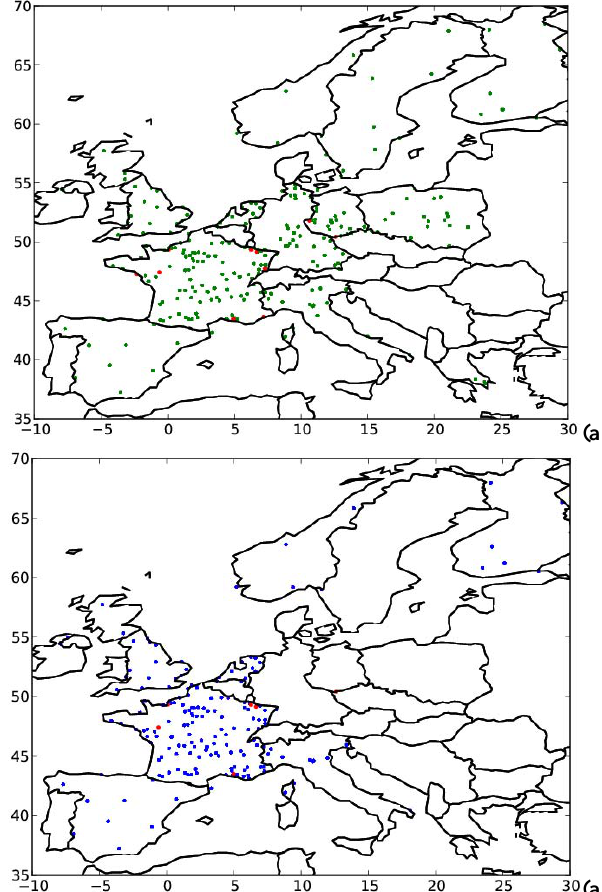
Fig. 8. Example of the location of MACC ozone rural ground-based stations, for the 1 July 2010 (a) and for the 1 December 2010 (b) ; the red points represent the validation